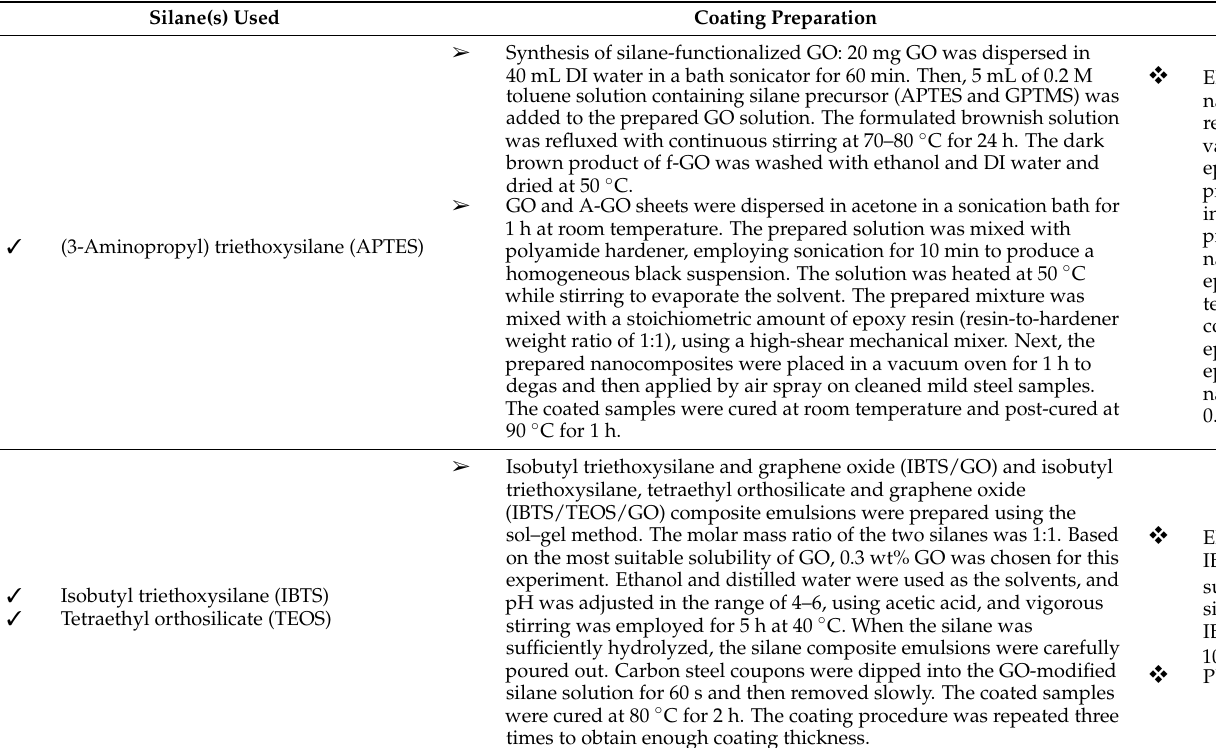
Table 1. Different approaches for improving silane coatings and the main findings, as reported in the literature. Silane(s)